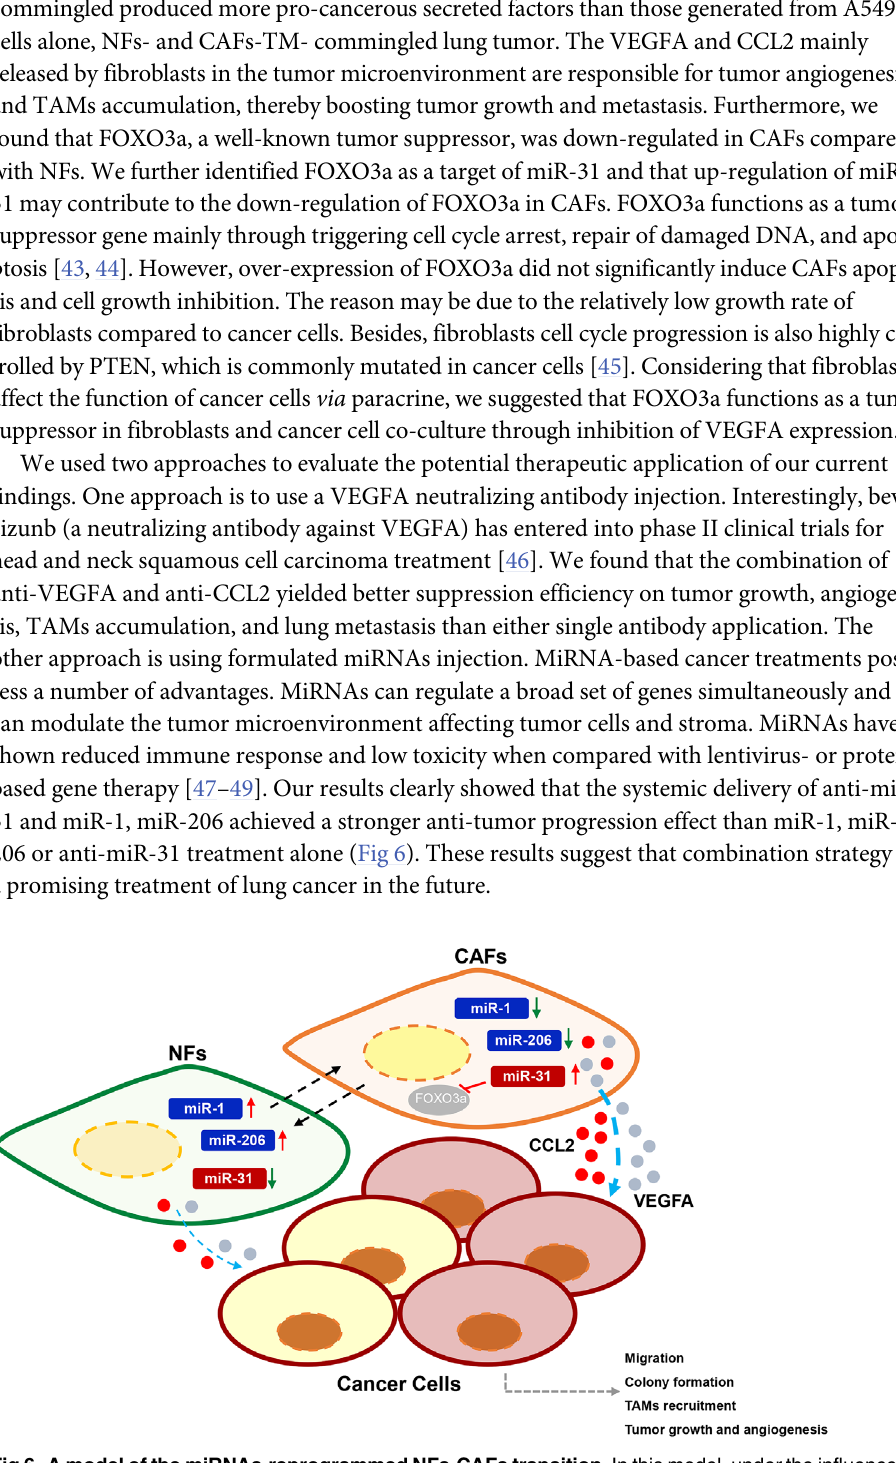
Fig 6. A model of the miRNAs-reprogrammed NFs-CAFs transition. In this model, under the influence of cancer cells, down-regulation of miR-1, miR-206 and up-regulation of miR-31 expression contribute to conversion of NFs to CAFs. The reprogrammed NFs (NFs-TM) or CAFs exhibit more efficient than NFs and reprogrammed CAFs (CAFs-TM) in promoting co-cultured cancer cell migration, colony formation, as well as TAMs recruitment, tumor growth and angiogenesis through increasing secretion of cytokines (CCL2 and